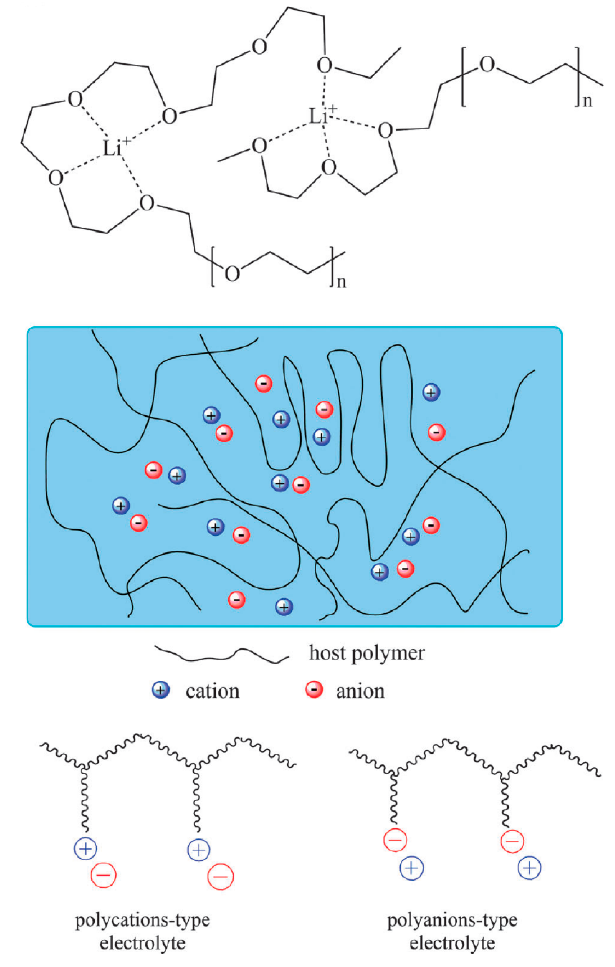
Figure 2. Dry solid polymer electrolytes PEO with Li + salt structure [35].